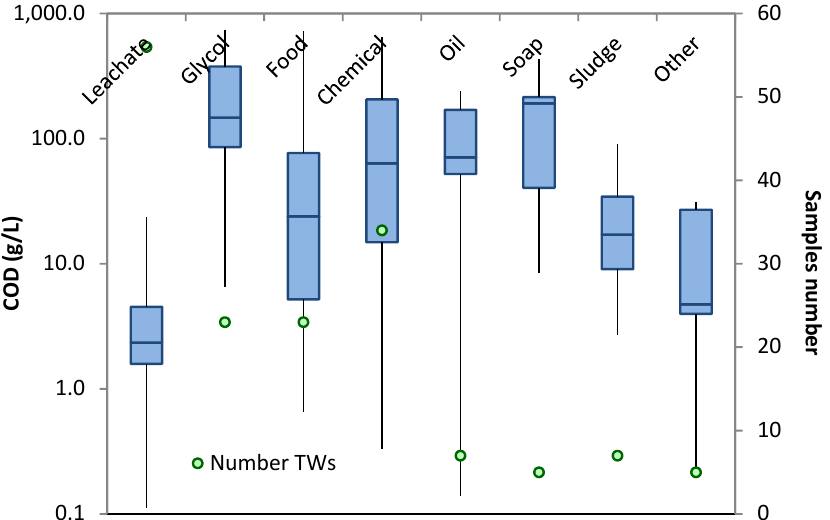
Figure 1. TWs divided by the type of industry where they were generated with their typical COD content.